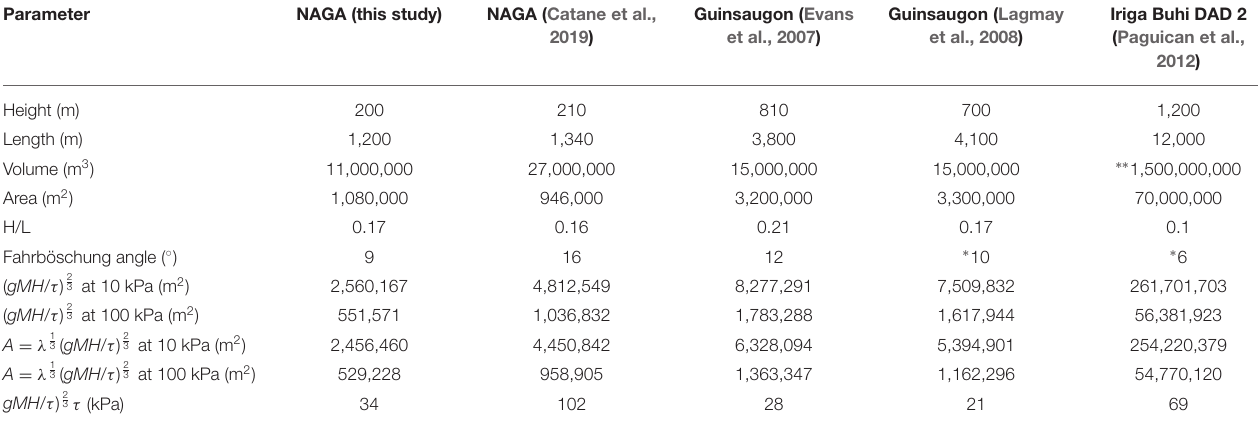
TABLE 1 | Computational analysis of Naga Landslide and other known Debris avalanches. Parameter